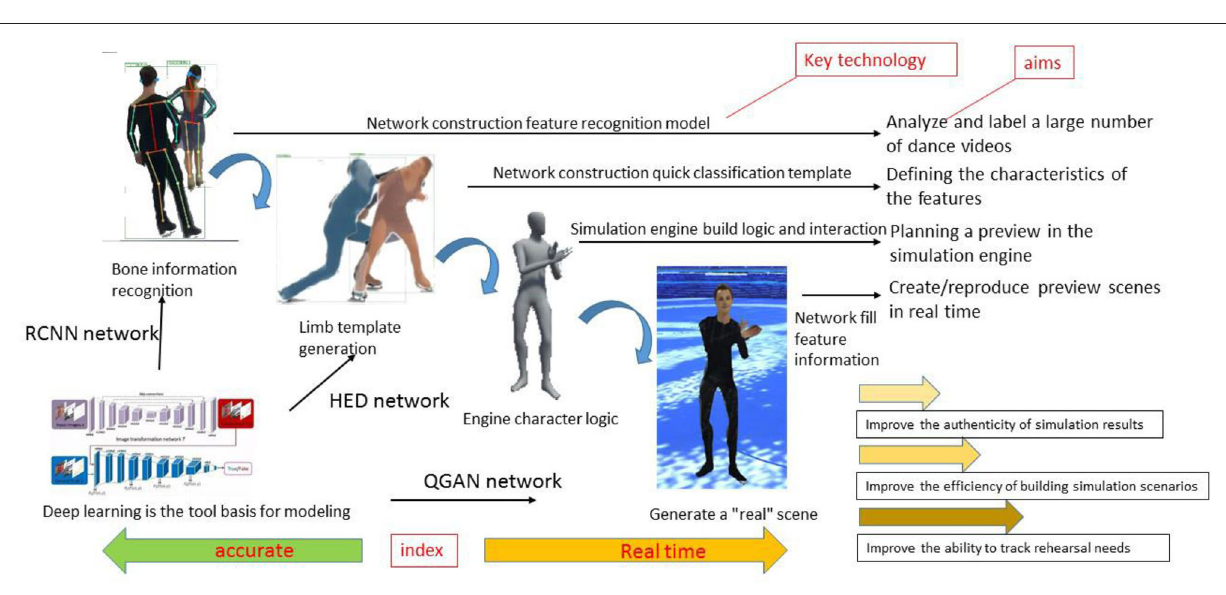
FIGURE 2 | The main links and key techniques of creative dance movements. HED, holistically nested edge detection; R-CNN, regional convolutional neural network; QGAN, quantum generative adversarial network. retrieval. This model not only enriches the knowledge structure but also promotes faster information